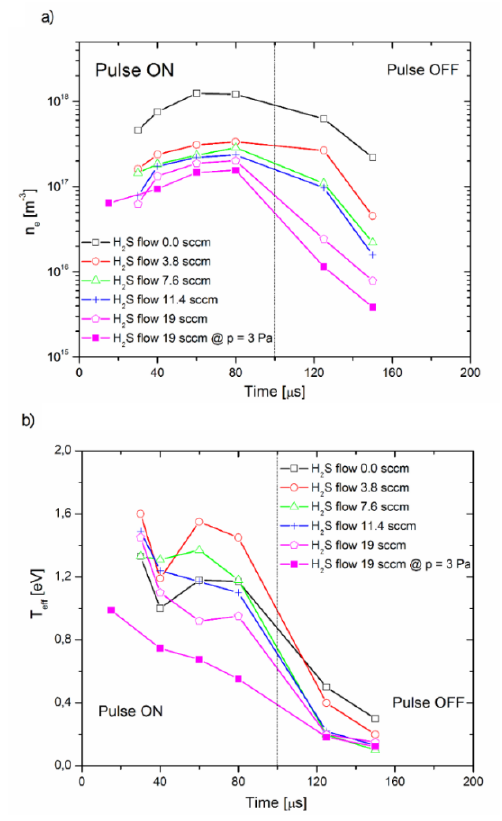
Figure 7. ( a ) Time evolution of electron concentration, n e , during HiPIMS pulse. ( b ) Time evolution of effective electron temperature, T eff , during HiPIMS pulse.